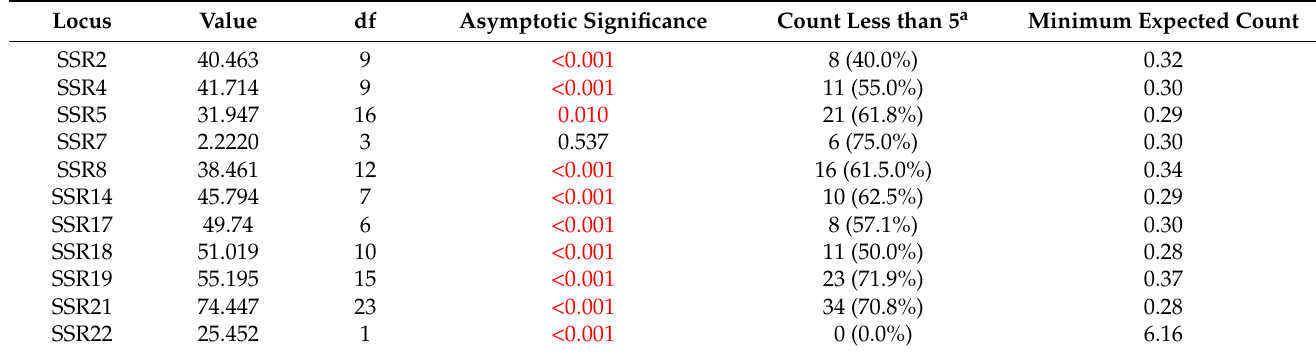
Table 2. Correlation analysis of SSRs and survival rate by chi-square test in strain A. Total of 11 loci, 10 of the 11 SSRs (except SSR7) that are statistically significant ( p < 0.05). Df means degrees of